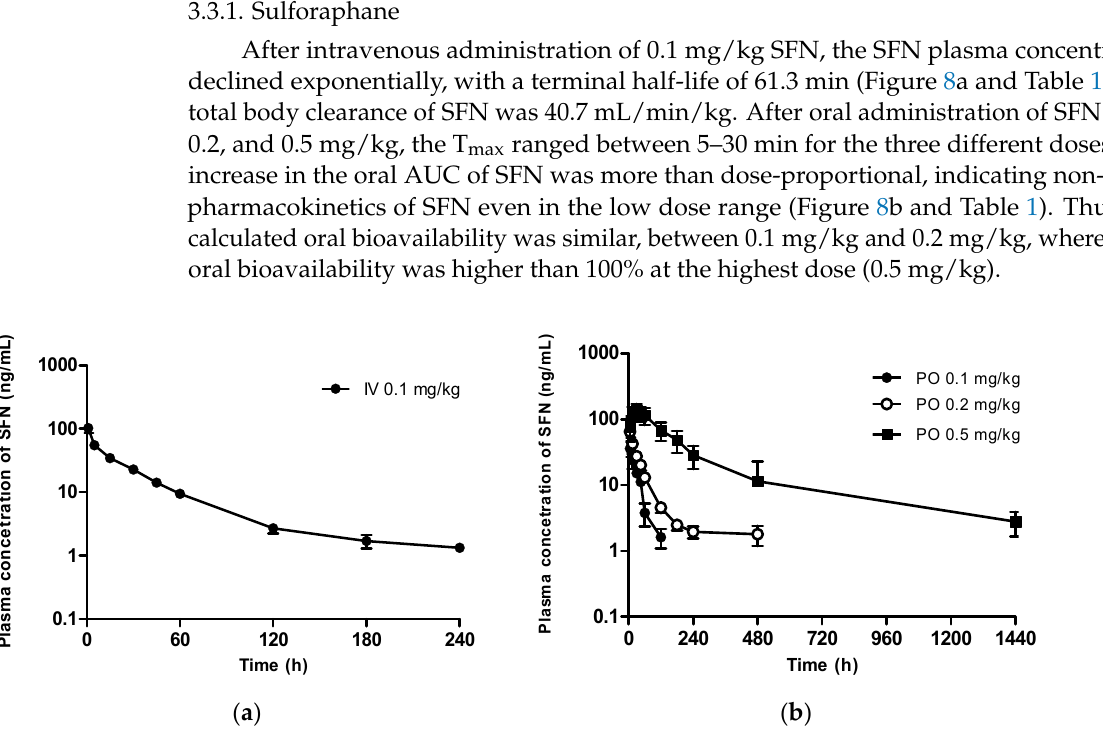
Figure 8. Plasma concentration of SFN after ( a ) intravenous (0.1 mg/kg) and ( b ) oral (0.1, 0.2, and 0.5 mg/kg) administration to rats. Data values are expressed as the mean ± standard deviation ( n = 4). SFN, sulforaphane. Table 1. Pharmacokinetic parameters of SFN after intravenous (0.1 mg/kg) and oral (0.1, 0.2, and 0.5 mg/kg) administration to rats. Data values are expressed as the mean ± standard